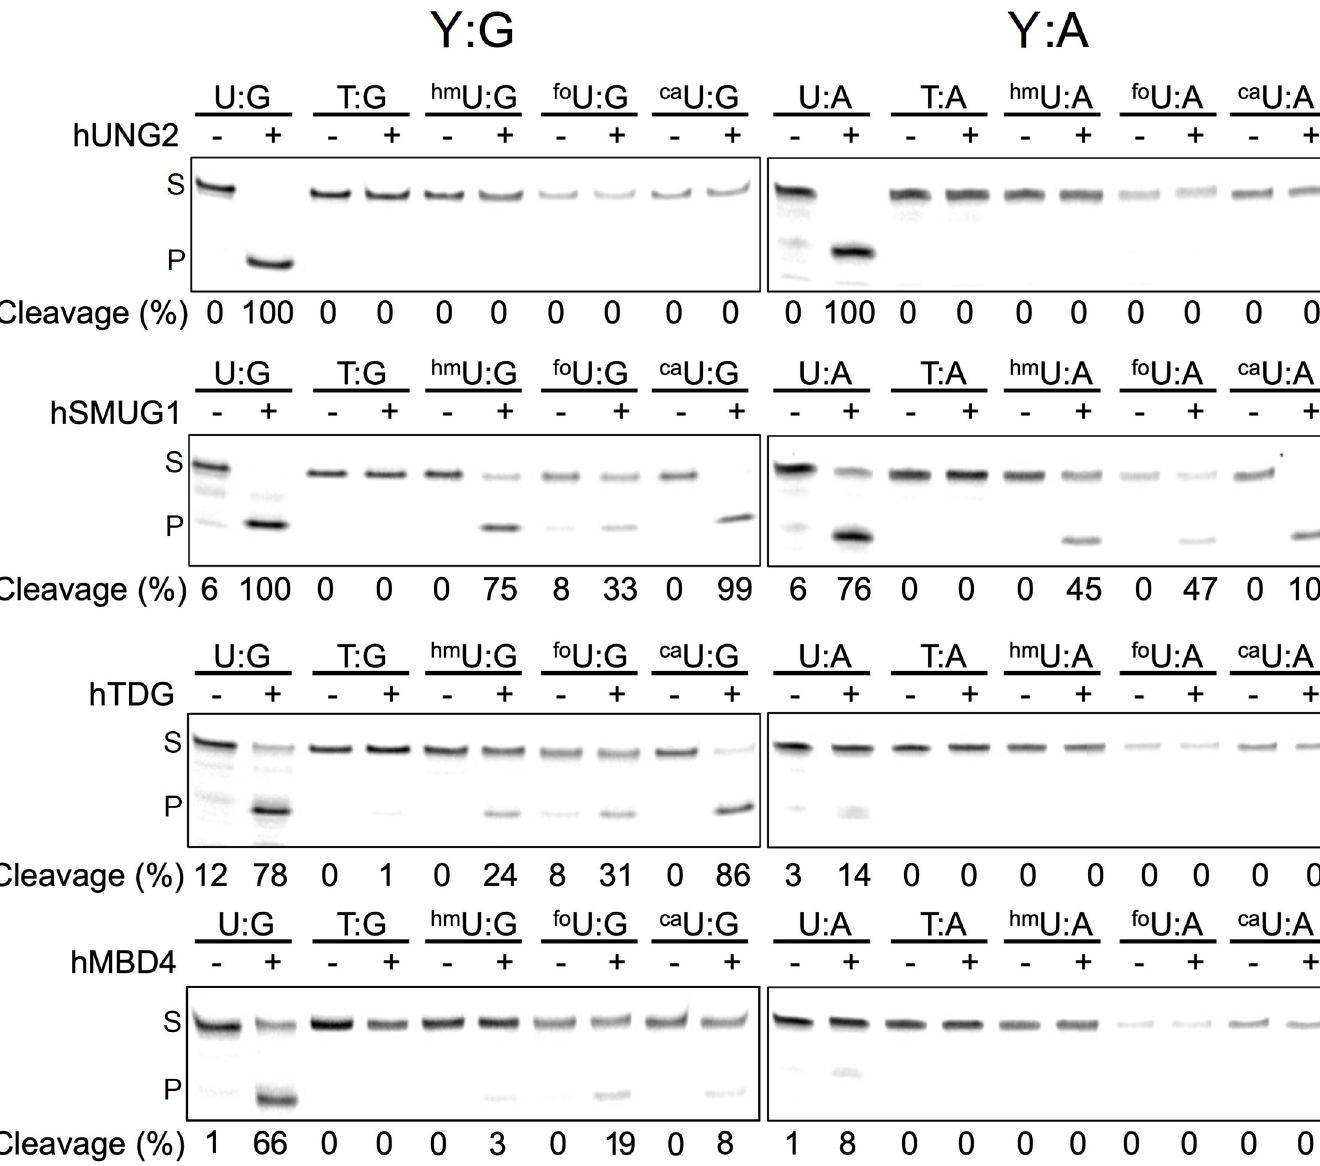
Fig 3. The excision specificity of human uracil family glycosylases for a series of 5-substituted uracil analogs (Y) paired with G (left) or A (right). FAM-labelled oligonucleotide duplexes (2.5 pmol) in buffer appropriate for each enzyme were incubated with a glycosylase at 37˚C for 1 h. Duplexes paired with G were then incubated with hyTDG-lyase (Y163K) (65˚C, 1 h) and those paired with A incubated with NaOH solution (96˚C, 10 min) to cleave the abasic site. Oligonucleotides were resolved on a 20% polyacrylamide/urea gel, visualized on a STORM imager, and quantified with “Image quant” software. The amount of cleavage is shown below the lanes in each gel (S = substrate, P = product). Some artifact cleavage of 5foU-containing oligonucleotides is observed due to its thermal lability. Replicate gel images are shown in S1 and S2 Figs in S1